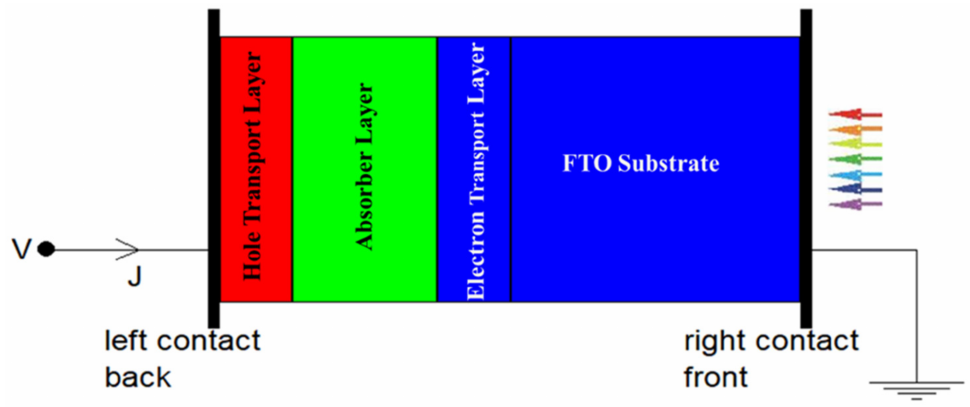
Figure 8. SCAPS simulation design of the PSC